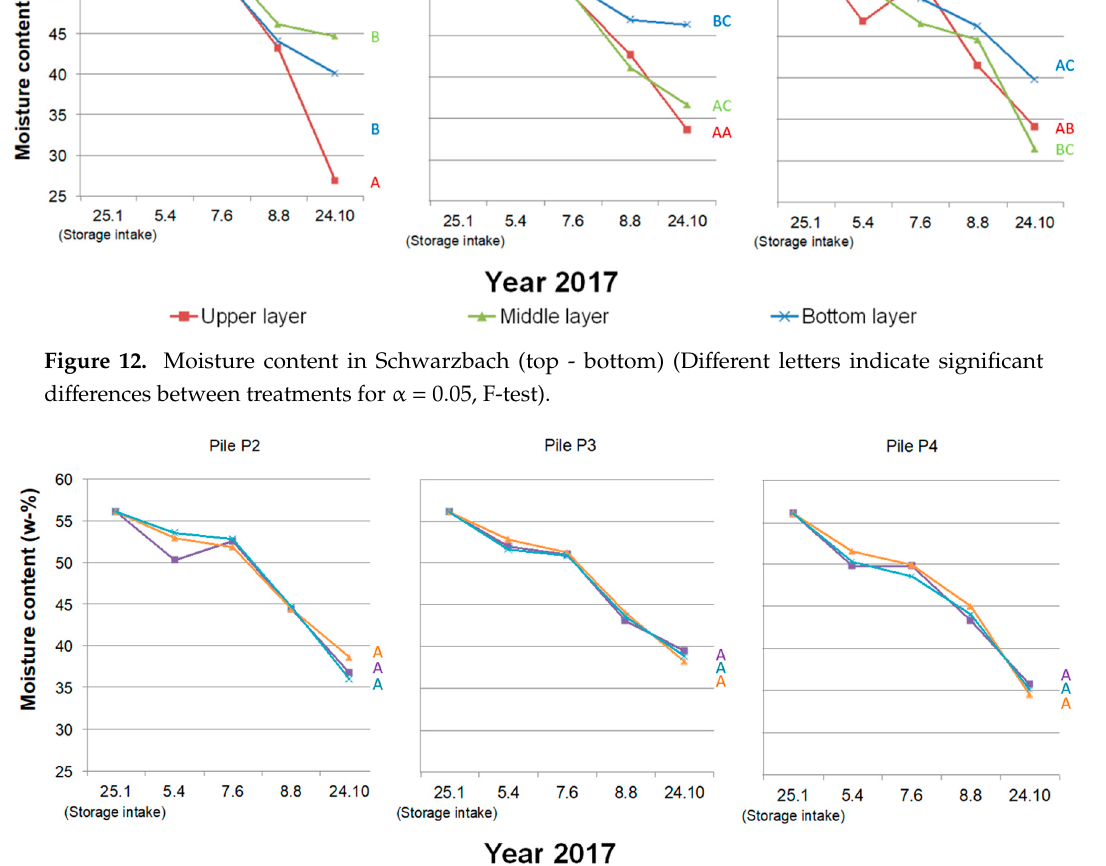
Figure 13. Moisture content in Schwarzbach (Foot-Crown) (Different letters indicate significant differences between treatments for α = 0.05, F-test).